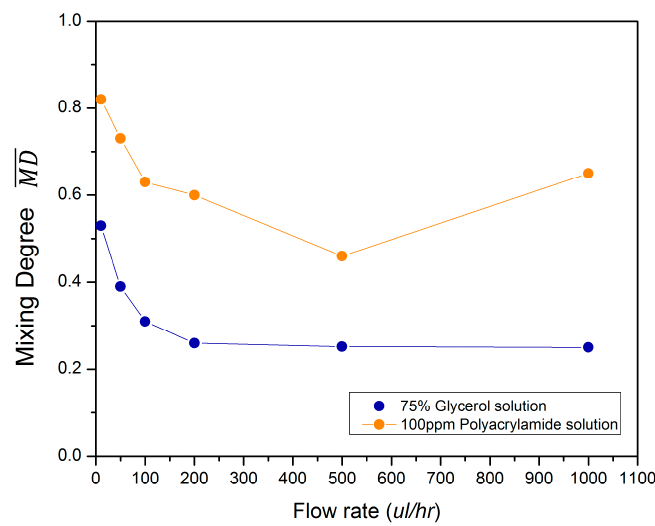
Figure 6. Mixing degree MD at S 2 = 2000 µ m at di ff erent flow rates for both glycerol and polyacrylamide (PAM).